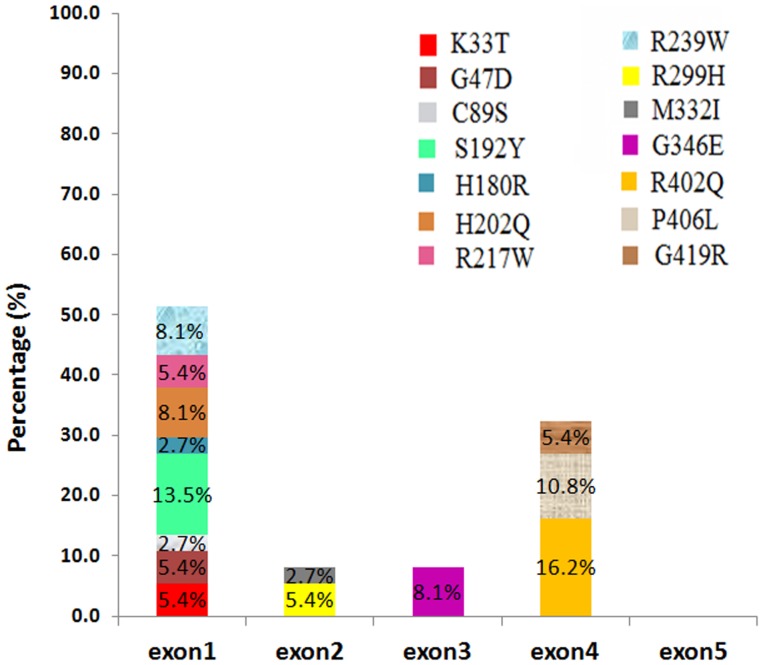
Distribution of mutations on the TYR gene in OCA1 patients.Bar diagram indicates the percentage of mutations that were found in this study.